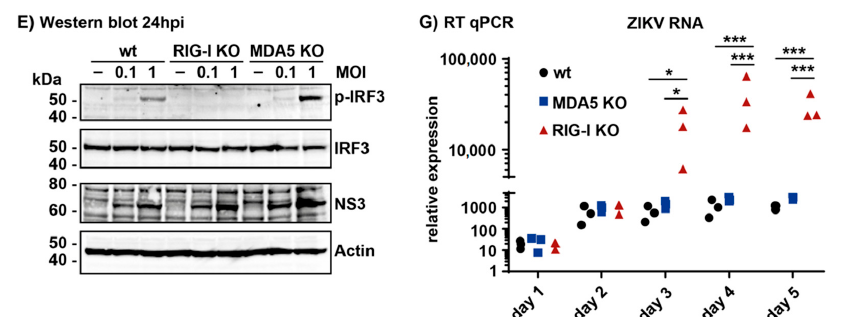
Figure 1. Retinoic acid-inducible gene I (RIG-I) is the main sensor for Zika virus (ZIKV) infection in A549 cells. ( A ) A549 cells were knocked-out for melanoma differentiation-associated gene 5 (MDA5) or RIG-I as described in Materials and Methods. Cells were stimulated with recombinant type I IFN (IFN-A/D) to induce MDA5 and RIG-I to detectable levels and lysates were analyzed by western blot using the indicated antibodies. Actin served as a loading control. The vertical line indicates a cut combining two parts of the same blot. c27, A14, B05 and B20 are individual clones. wt, wild type; ( B ) Genomic DNA was extracted from MDA5 KO clone c27 or RIG-I KO clone B05 cells. A fragment of DNA surrounding the targeted area was amplified by PCR and sequenced (left). Sequences were analyzed using TIDE (right). The number of nucleotides inserted or deleted, and the percentage of sequences affected are shown; ( C ) A549 MDA5 KO or RIG-I KO cells (clone B05) were infected with ZIKV (MOI 0.1 or 1), supernatant was collected 24 h later and IFN β levels were analyzed by ELISA. The horizontal dashed line indicates the detection limit; n.d., not detectable; ( D ) A549 cells were infected with ZIKV (MOI 1) and supernatant was collected 48 h later. HEK293 cells stably expressing the pGF1-ISRE reporter were incubated with the supernatant and F-Luc activity was measured after 24 h. Shown is the fold induction relative to supernatant from mock infected cells. ( E ) A549 cells were infected with ZIKV (MOI 0.1 or 1), protein samples were collected 24 h later and analyzed by western blot using the indicated antibodies. Actin served as a loading control; ( F ) A549 cells were infected with ZIKV (MOI 1 or 5) and RNA was isolated 24 h later. Levels of IFIT1 and MX1 mRNAs were determined with RT-qPCR and C T values normalized to GAPDH ; ( G ) A549 cells were infected with ZIKV (MOI 0.1) and RNA was isolated at the indicated time points. RT-qPCR was performed and ZIKV RNA levels are presented relative to GAPDH . Data in A , C and E are representative of two independent experiments. Data in D , F and G are pooled from three ( D , G ) and four ( F ) independent experiments. Each data point is the mean value of two technical replicates. Statistical analysis: One-way ( D ) and two-way ( F , G ) ANOVA with Tukey’s multiple comparison (* p < 0.05, *** p <